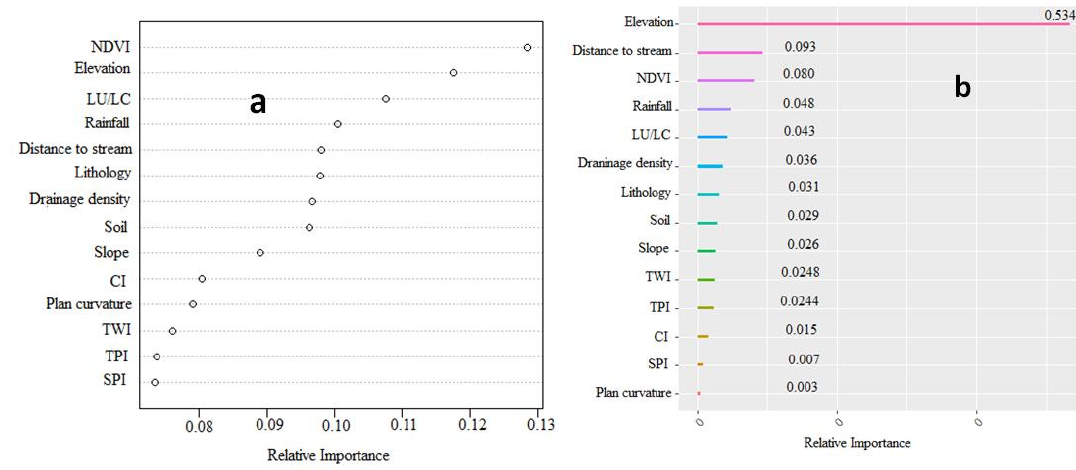
Figure 10. Relative importance of flood conditioning factors using ( a ) AdaBoost model ( b ) boosted regression tree (BRT).